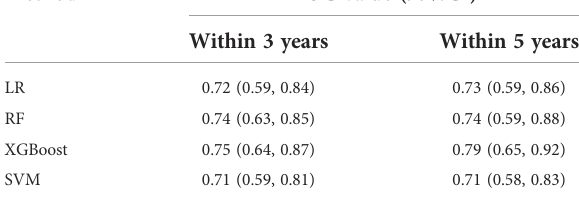
TABLE 4 AUC value comparison of “ TCM syndrome prognostic model ” .